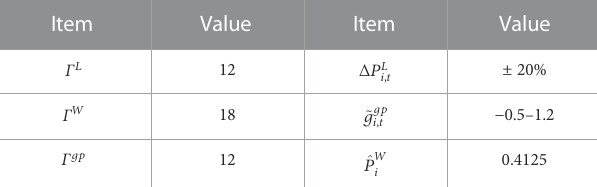
FIGURE 3 Power load and natural gas demand.